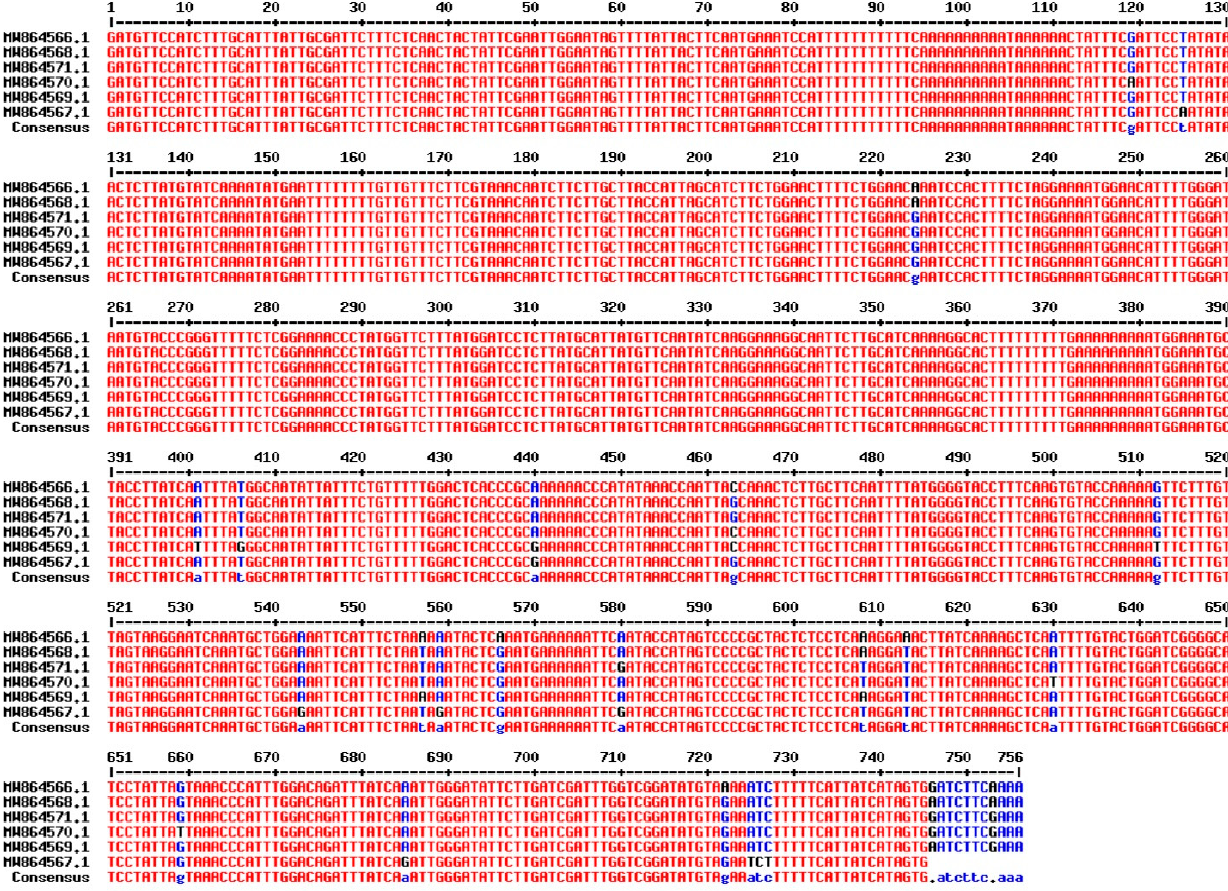
Figure 7. Sequence alignment of matK gene of the selected six T. aestivum genotypes using Multalin ver.5.4.1 (http://multalin.toulouse.inra.fr/multalin/, accessed on 15 August 2022 ).